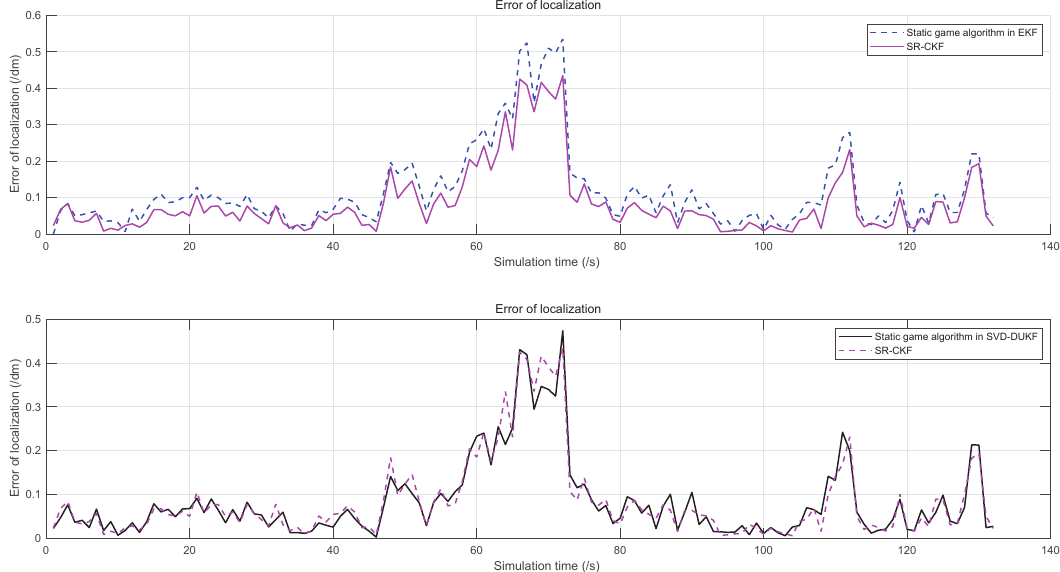
Figure 10. The error of localization on the game theory EKF, square root cubature Kalman filter (SR-CKF), and the game theory SVD-DUKF.